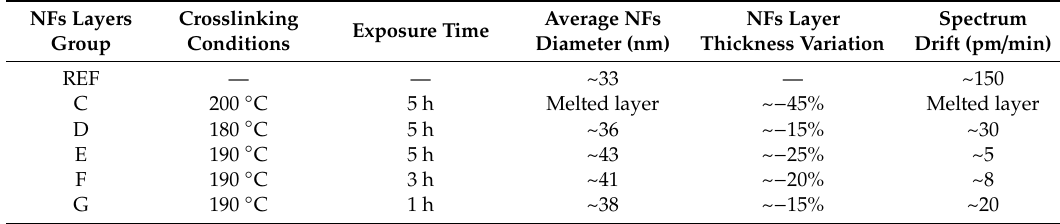
Table 2. Crosslinking conditions and morphological evaluation of NFs layers after the thermal treatments.